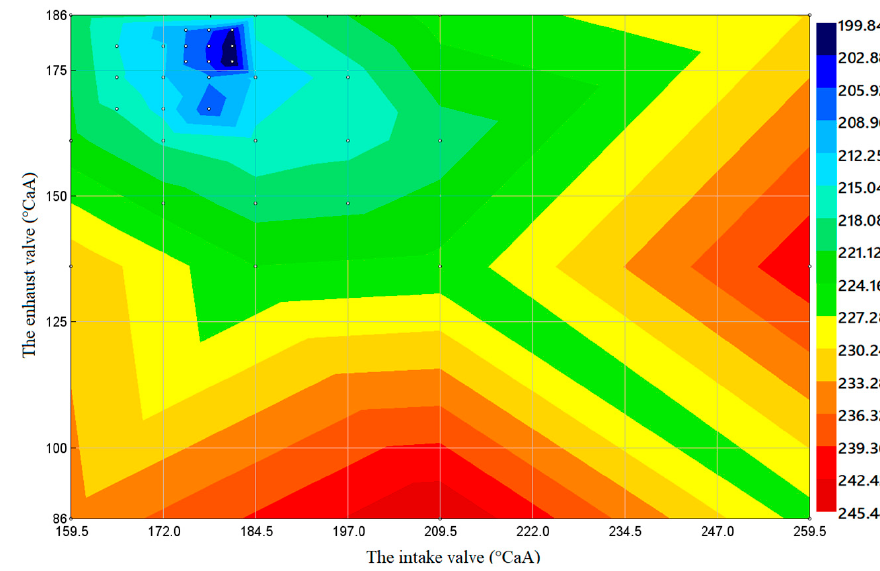
Figure 12. 100% load